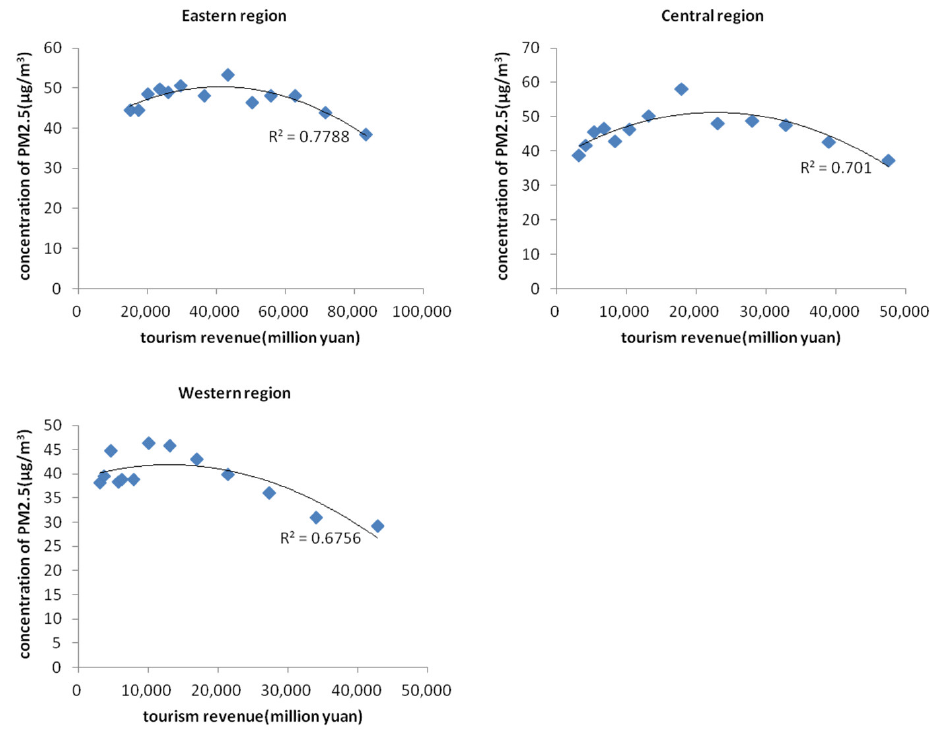
Figure 2. Scatter diagram of tourism revenue and PM 2.5 concentration in eastern/central/western region.